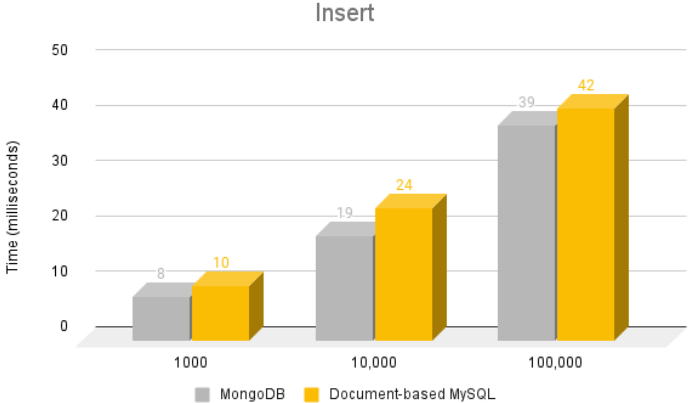
Figure 3. Execution times for the insert operation.